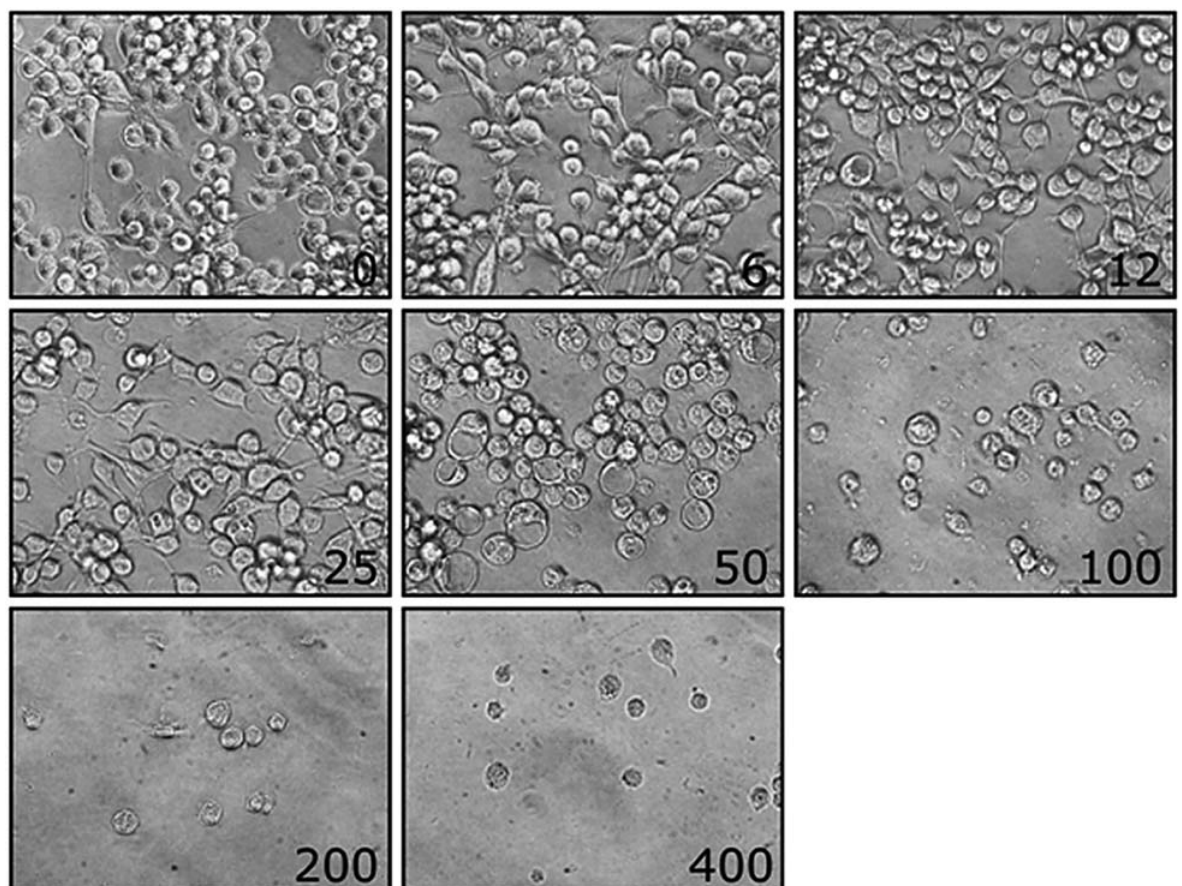
Figure 2 – Photomicrography of the MB49 bladder tumor cell culture exposed to variable concentration of curcumin, showing progres- sive apoptosis. In concentrations above 100 mM there are no viable